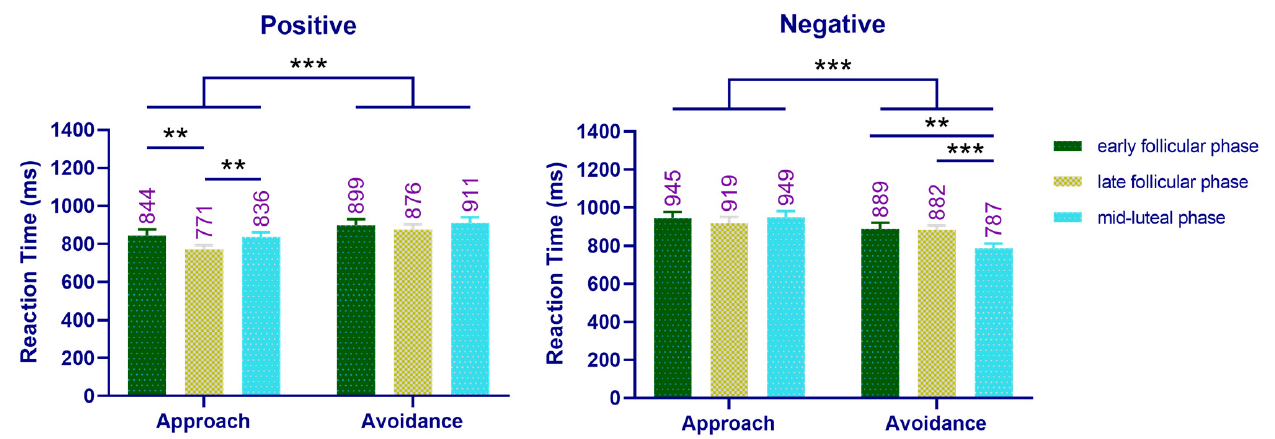
Figure 6. Reaction time of the improved “manikin task” across the cycle phases in Experiment 2. Left: the reaction time of women performing approach–avoidance behavior to a positive emotional picture across the cycle phases. Right: the reaction time of women performing an approach–avoidance behavior to a negative emotional picture across the cycle phases. Mean RT above bar. Error bars represent the standard error of the mean. *** p < 0.001; ** p < 0.01 .